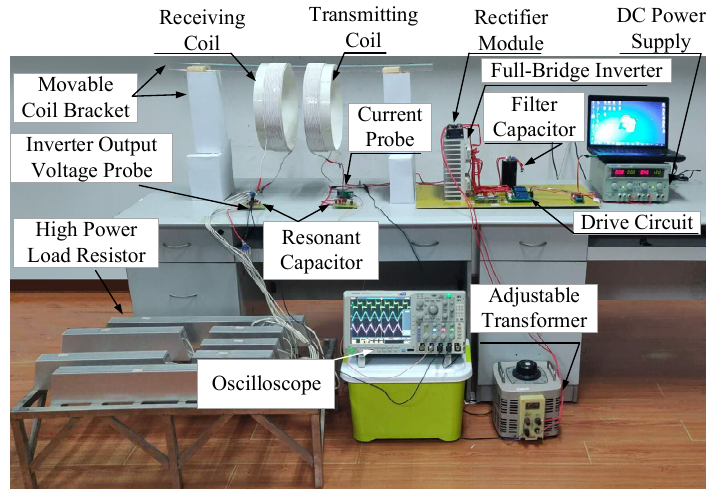
Figure 8. The experimental platform of the MCR ‐ WPT system.